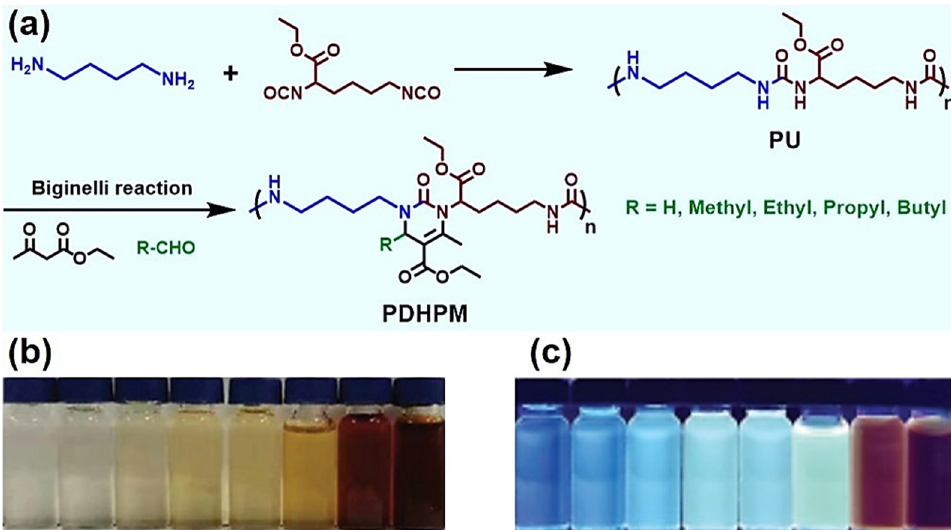
Figure 12. AIE-active polymers (PDHPM) from a non-AIE-active polyurea (PU) produced via the Biginelli reaction. ( a ) The synthesis of PU and PDHPMs; ( b , c ) PDHPM (R = propyl) in DMSO solutions with different concentrations (from left to right (mg/mL): 0.05, 0.1, 0.25, 0.5, 1, 5, 10, and 20) under ( b ) natural light and ( c ) UV = 365 nm. Reprinted with permission from ref. [67]. Copyright © 2021 Wiley-VCH GmbH. All rights reserved.